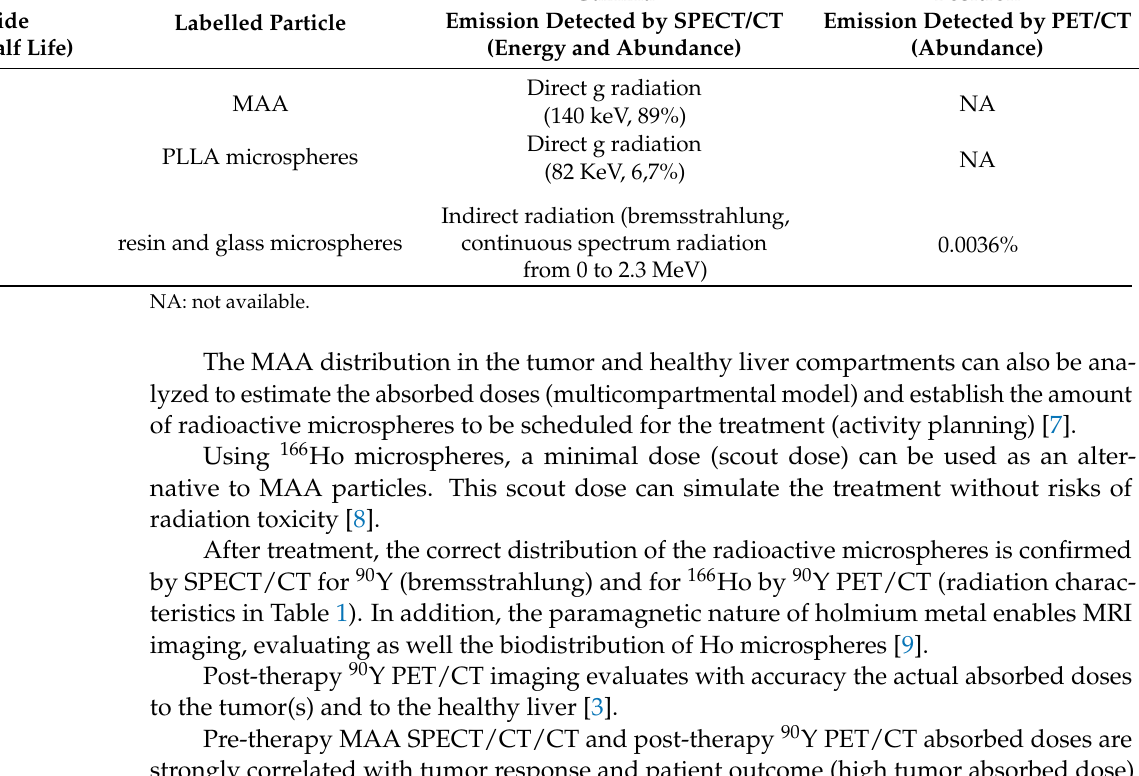
Labelled Particle